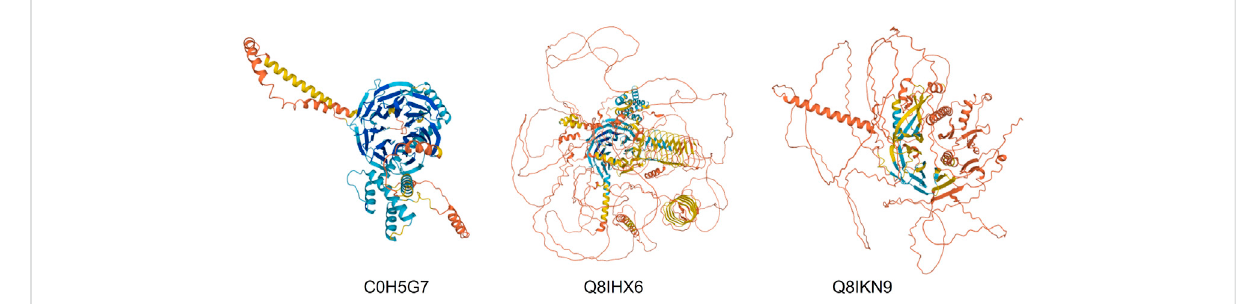
FIGURE 9 AlphaFold models of three P. falciparum WD40 propellor proteins bound to PfCCT.